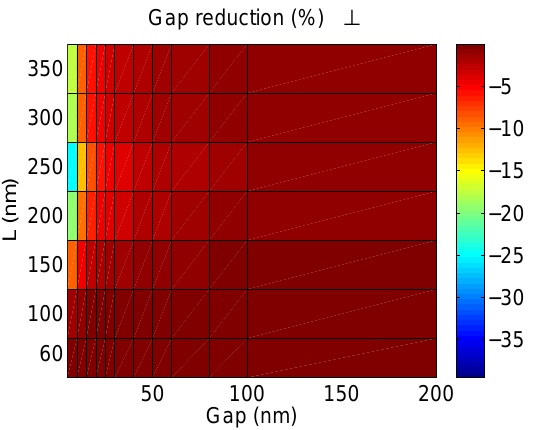
Figure 13: Relative reduction of the gap, (%) , as a function of the particle length L and the gap for parallel polarization.